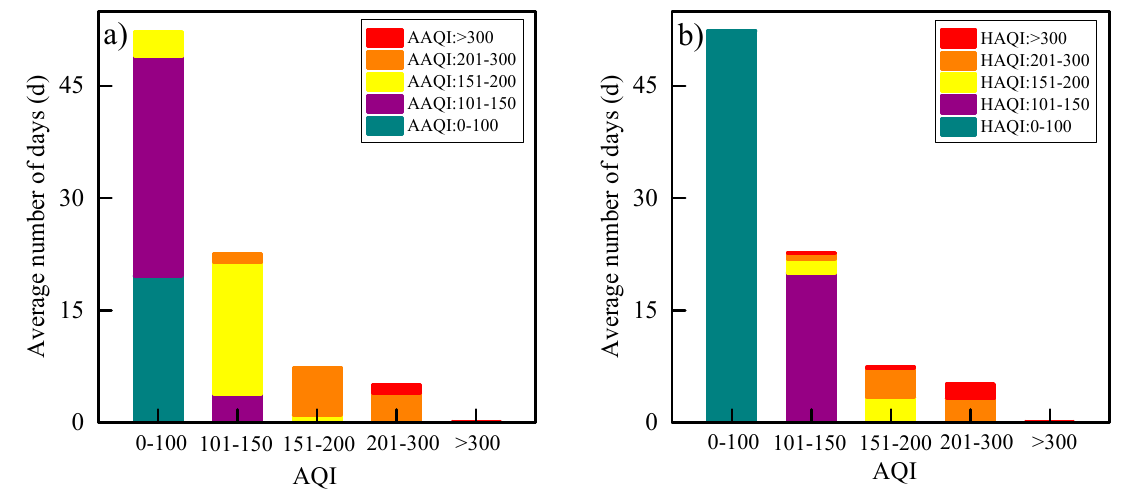
Figure 8. Comparisons of AQI-classified health risk categories with the ( a ) AAQI and ( b ) HAQI classifications (averaged data from 29 cities).